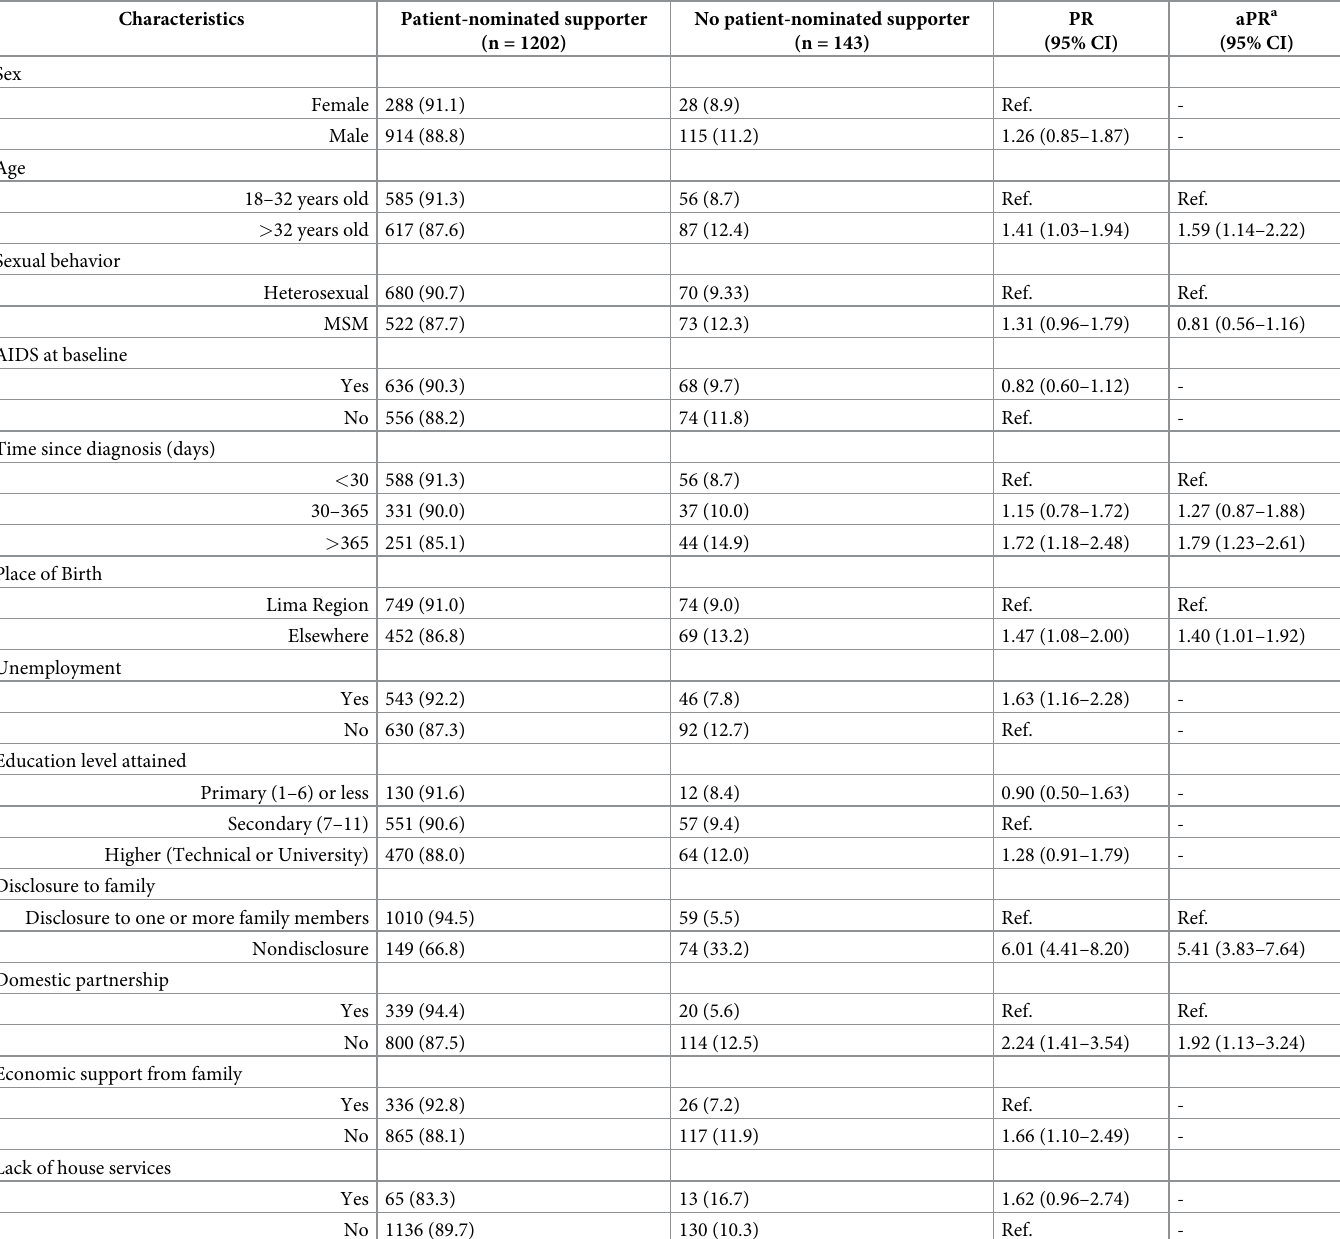
Table 2. Factors associated with not having a patient-nominated supporter among people living with HIV who were evaluated by a social worker, 2011–2014.